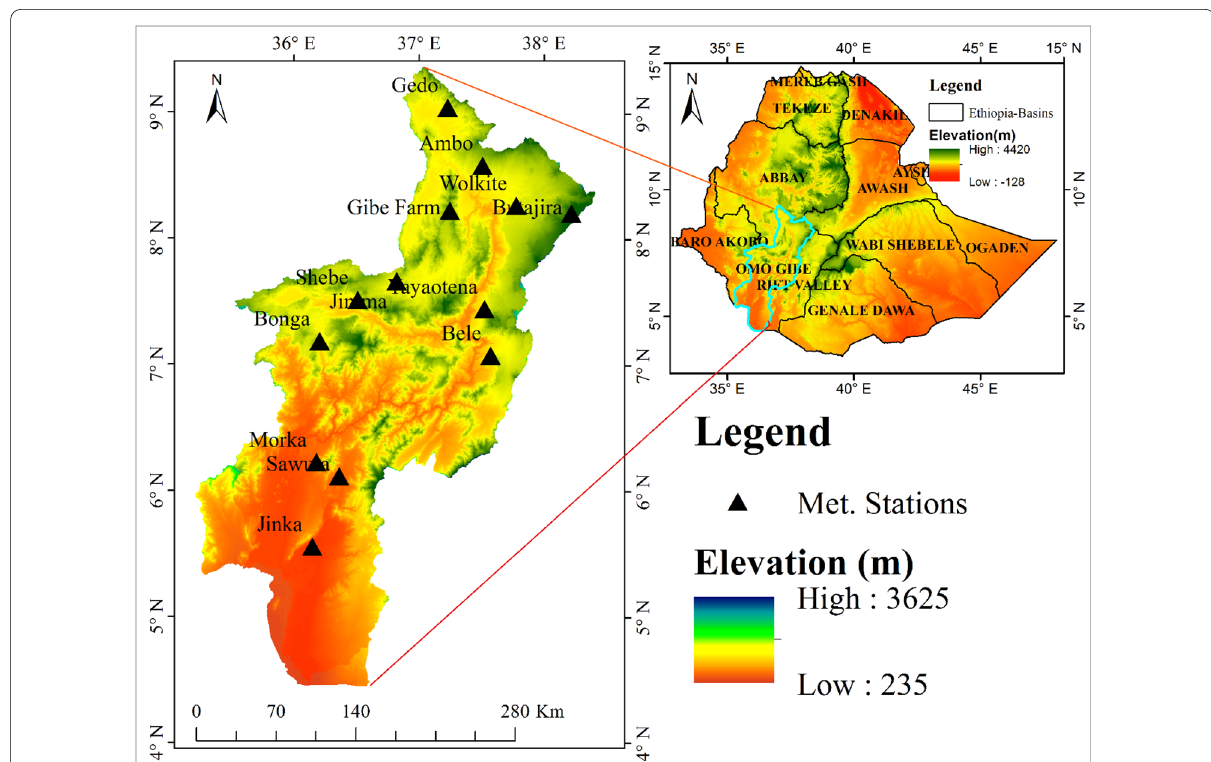
Fig. 1 Topographic map and spatial distribution of the meteorological stations in the